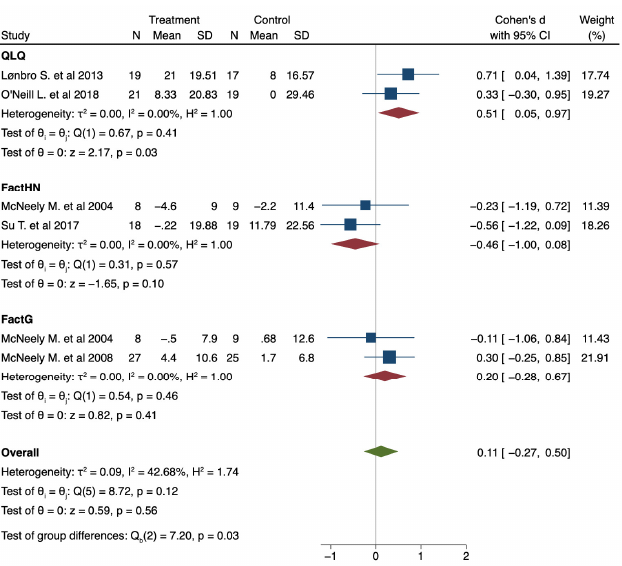
Figure 4. Forest plot presenting the effect of exercise on the improvement of Quality of Life (QoL) measured with different instruments in patients with Head and Neck cancer (HNC) compared with control; pre–post intervention data. Values on x-axis denote Cohen’s d. The diamond illustrates the 95% confidence interval of the pooled